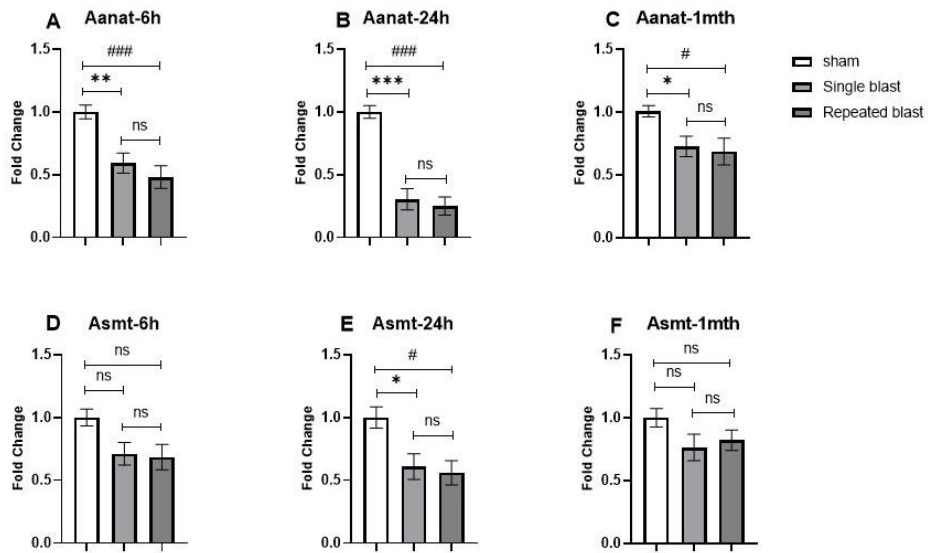
Figure 5. Effects of single and repeated blast exposure on Aanat and Asmt mRNA levels at night in the pineal glands of rats. Aanat mRNA concentrations at ( A ) 6 h, ( B ) 24 h, and ( C ) 1 month after blast injury. Asmt mRNA concentrations at ( D ) 6 h, ( E ) 24 h, and ( F ) 1 month after blast injury. Results are expressed as means ± SEM (n = 6); *** p < 0.001, ** p < 0.01, and * p < 0.05 for sham vs. single blast group; ### p < 0.001, and # p < 0.05 for sham vs. repeated blast group; ns — not significant.